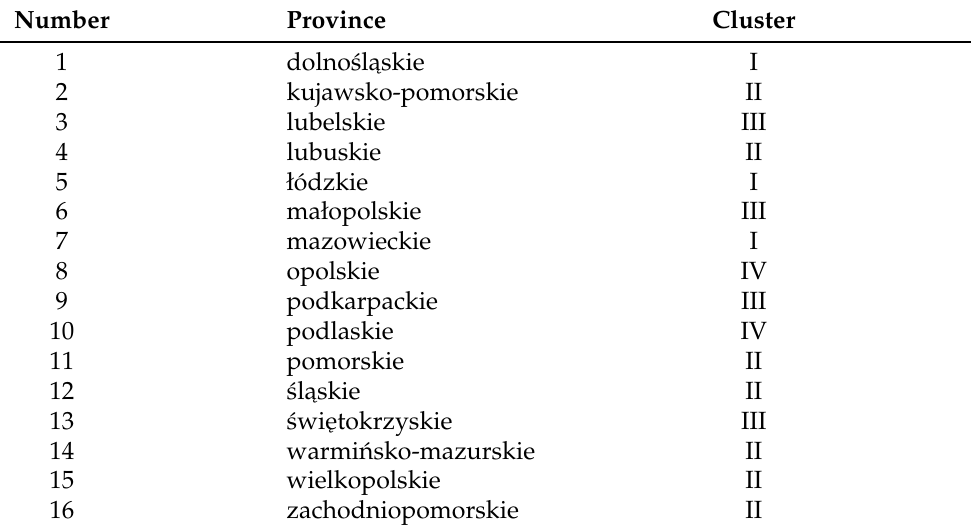
Table 6. Membership of provinces in the four